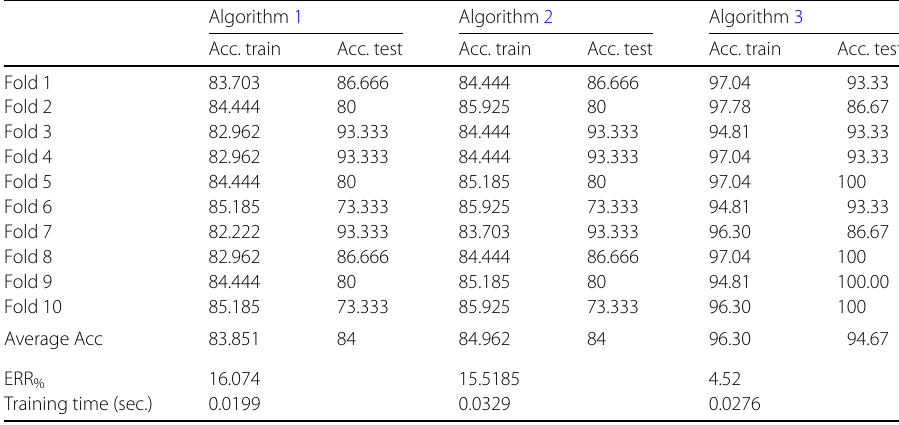
Table 9 Comparison of each algorithm at the 100th iteration with 10-fold CV. on Iris